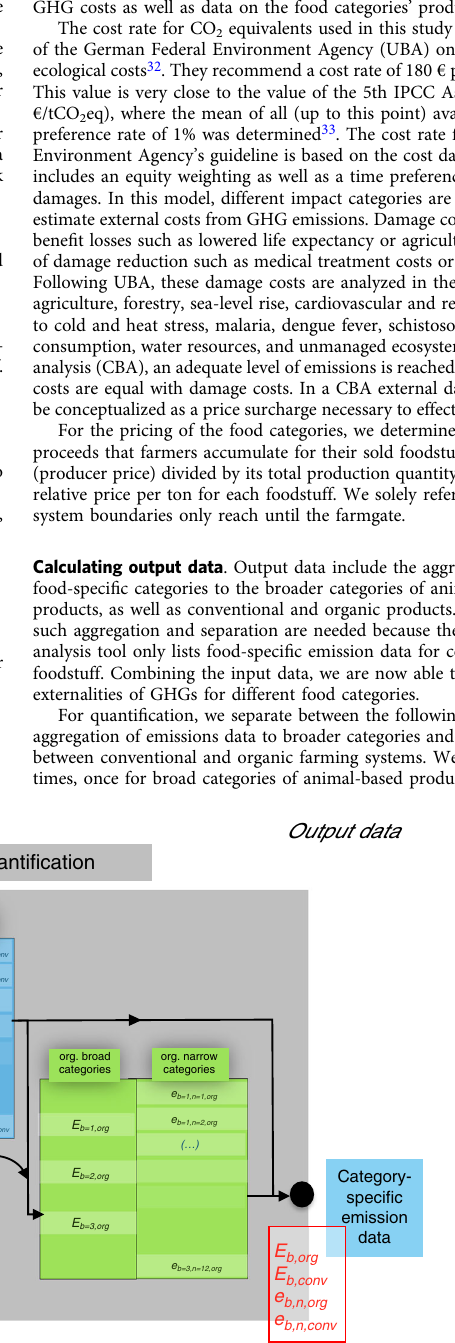
Fig. 4 Visualization of the quanti fi cation process. Quanti fi cation as well as corresponding input and output data are displayed. Data from the Global Emissions Model for Integrated Systems (GEMIS) 44 ( g b,n,i,conv ) and production data 88 – 90 ( q b,n,i,conv ) are combined, and emission data for broad ( E b,conv ) and narrow ( e b,n,conv ) categories are derived for conventional production. Organic emission values are calculated by multiplication of conventional emission values ( E b,org and eb,n,org ) with the emission difference ( D b,org/conv ) (cf. “ Input data for quanti fi cation ”